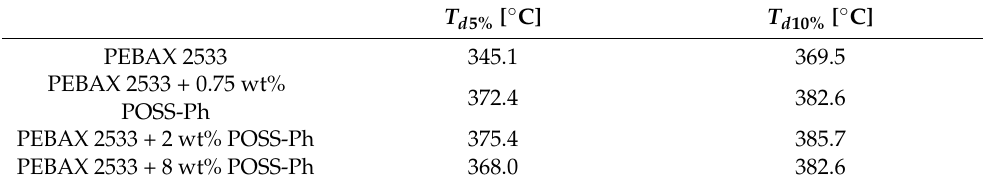
Table A3. Temperatures at which the weight of the sample decreases by 5 wt% and 10 wt% for a membrane containing different concentrations of POSS-Ph.